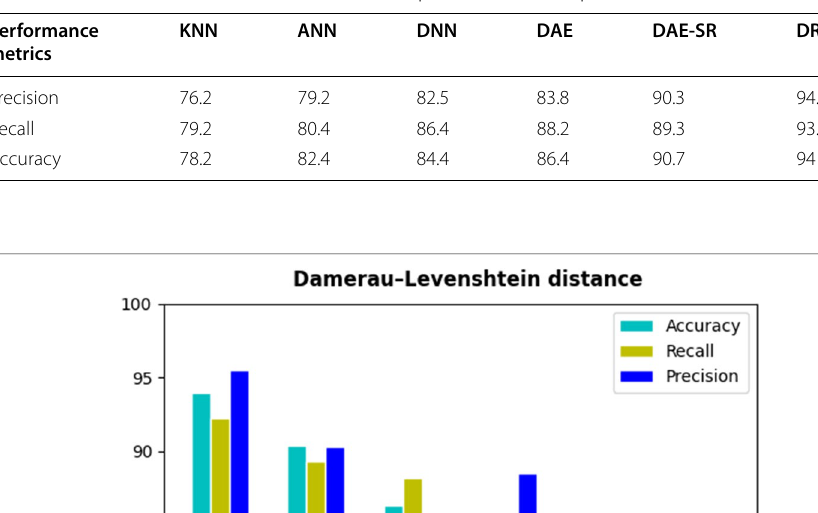
Table 4 Damerau–Levenshtein distance based performance comparison